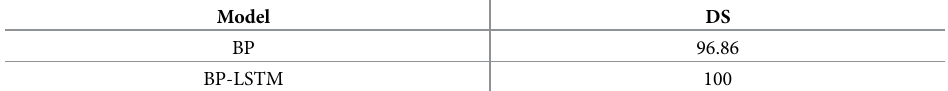
Table 3. Comparison of directivity prediction accuracy of different models.